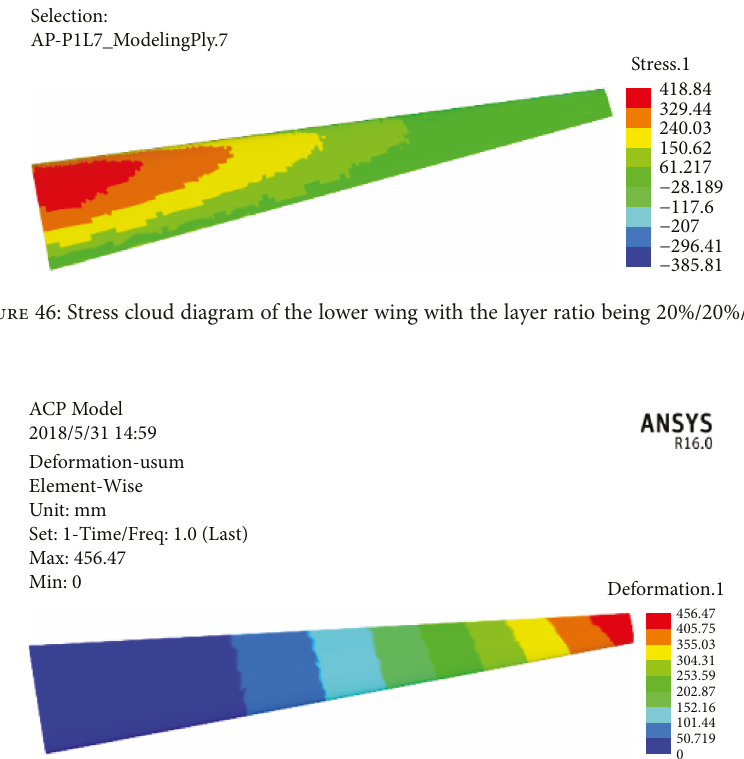
Figure 47: Deformation cloud diagram with the layer ratio being